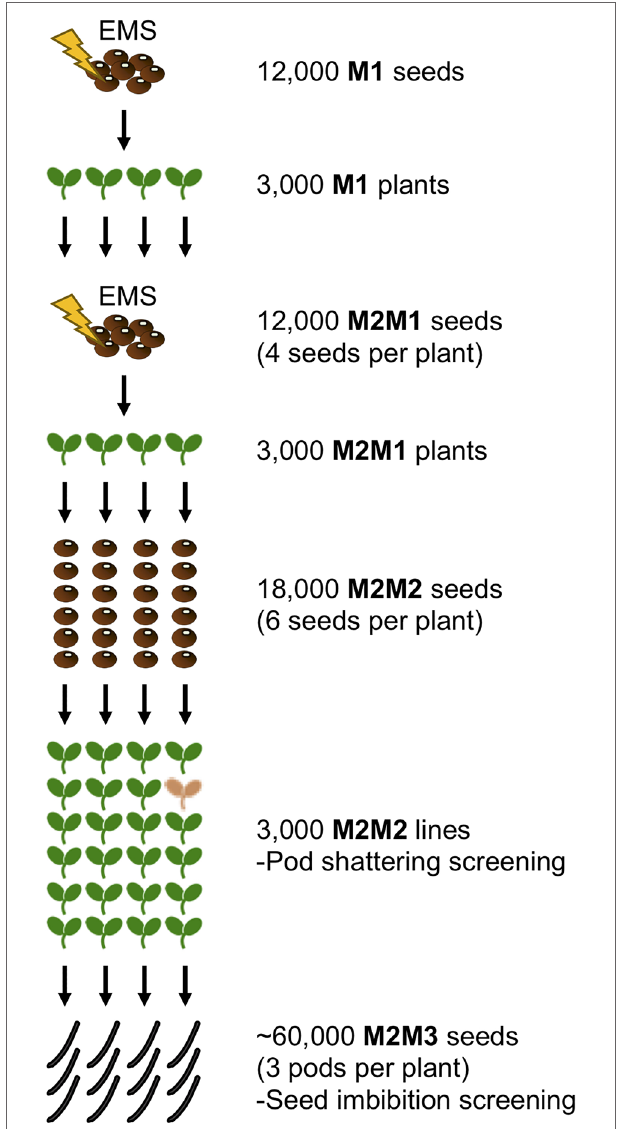
FIgURe 1 | Schematic of domesticating V. stipulacea. After two rounds of EMS treatment, 3,000 M2M1 plants were selected to collect M2M2 seeds (six per line). The 18,000 M2M2 plants were grown in a field, where pod shattering mutants were screened for. Three pods (~20 seeds) per plant was harvested, which were tested for seed-imbibition